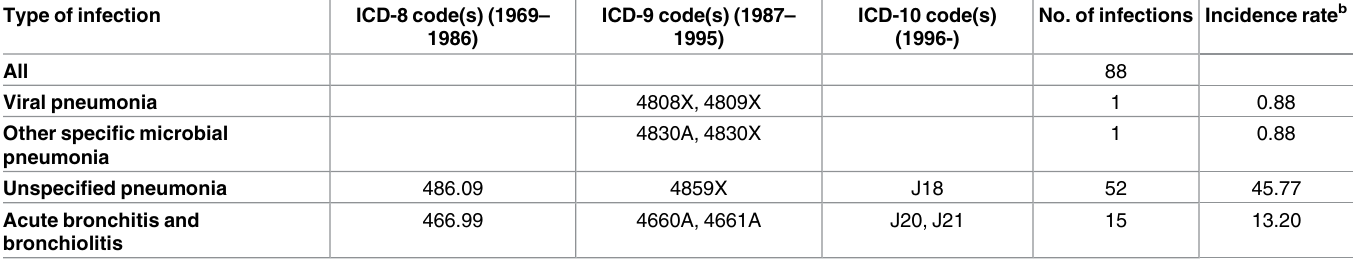
Table 1. Numbers and incidence rates of lower respiratory tract infections leading to hospitalization from birth to the age of 7 years, The Espoo Cohort Study, 1991–2011 a . Type of